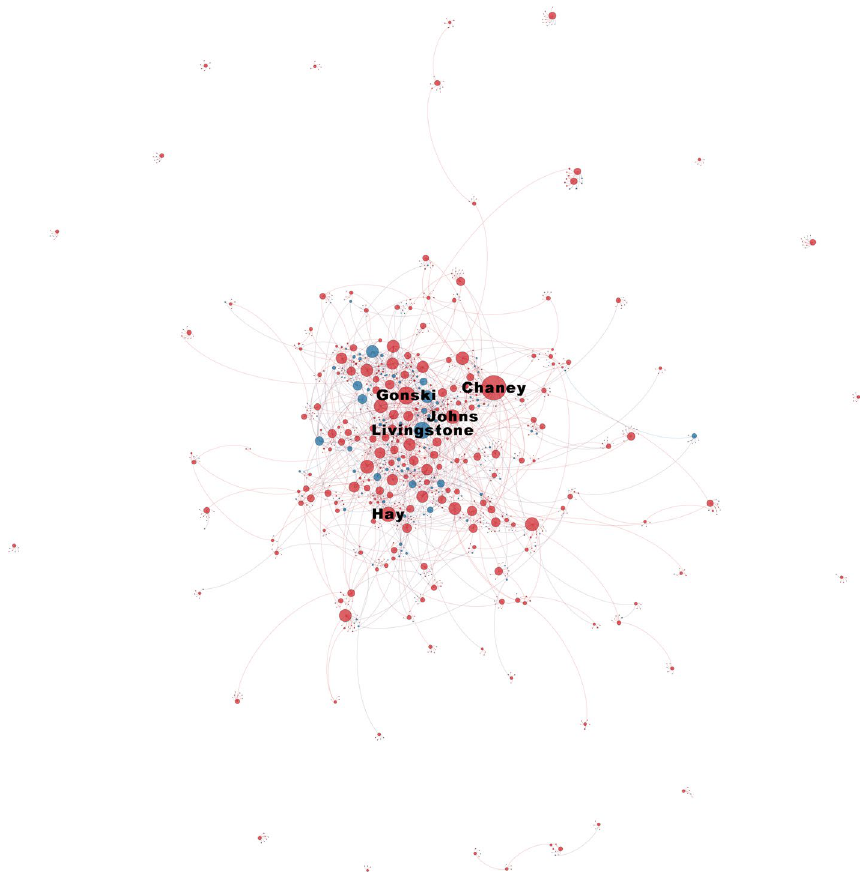
Fig. 4 Network Graph: Node Degree Centrality